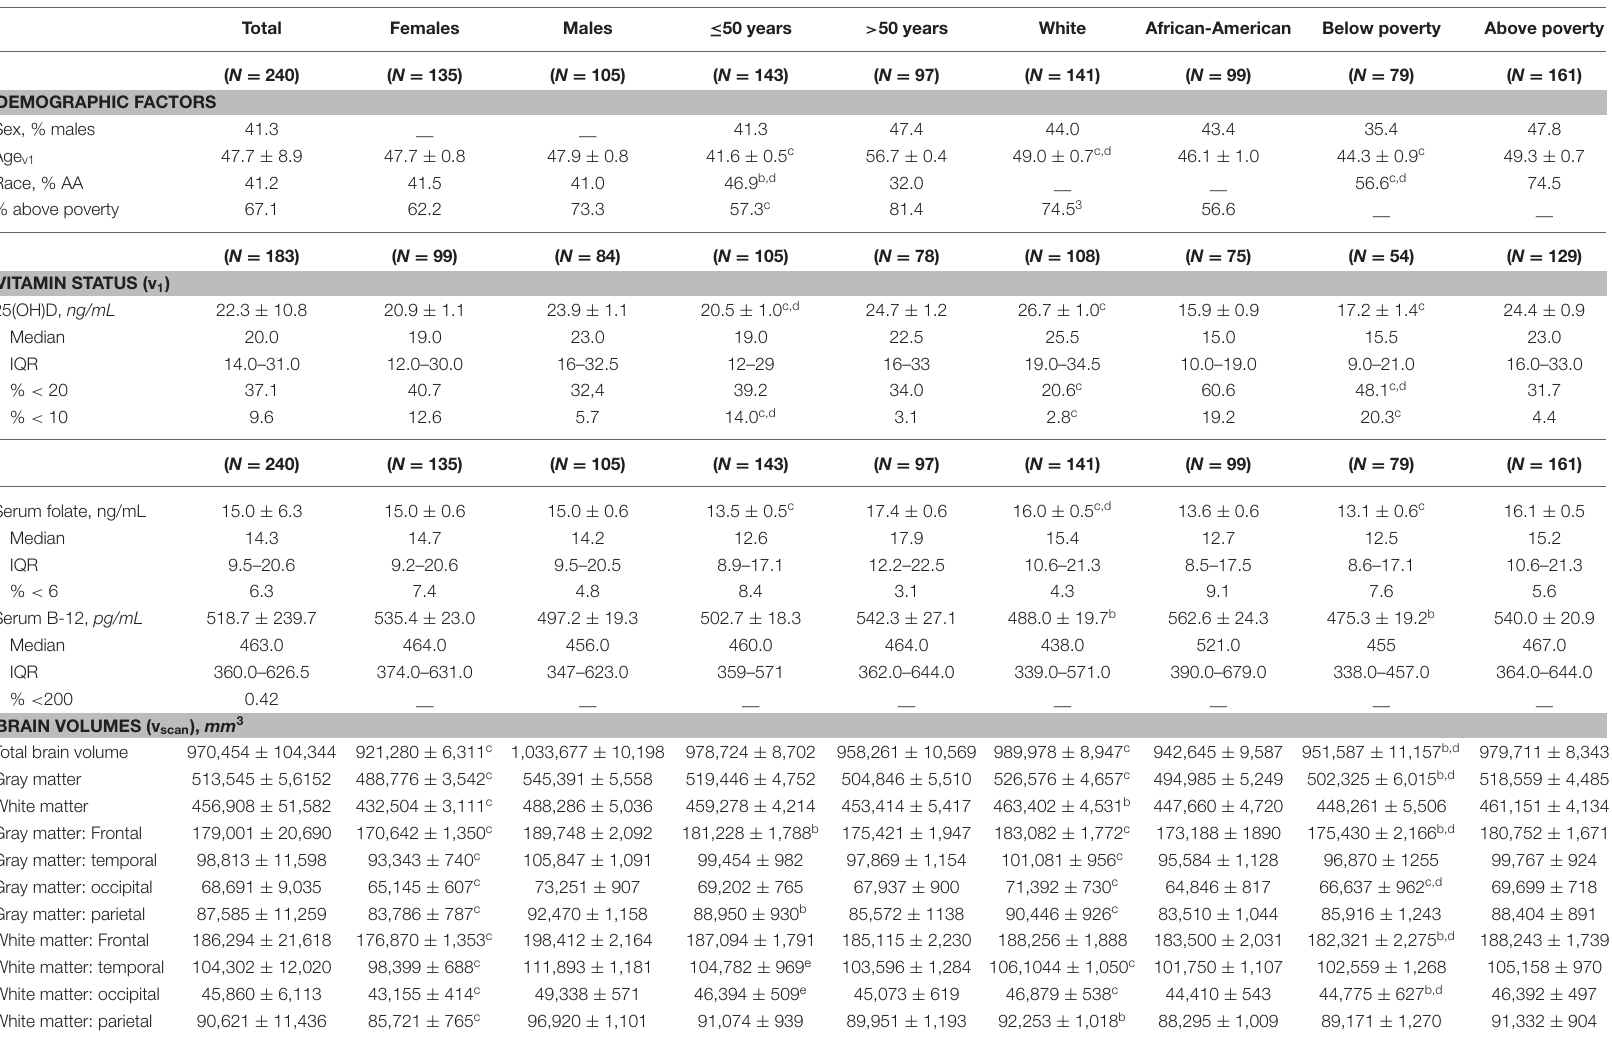
TABLE 1 | Study sample characteristics by sex, age group, race and poverty status; HANDLS 2004–2009 and HANDLS-SCAN 2011–2015 a